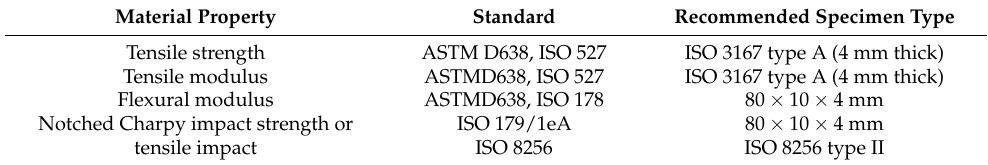
Table 3. Mechanical tests and methods for thermoplastics